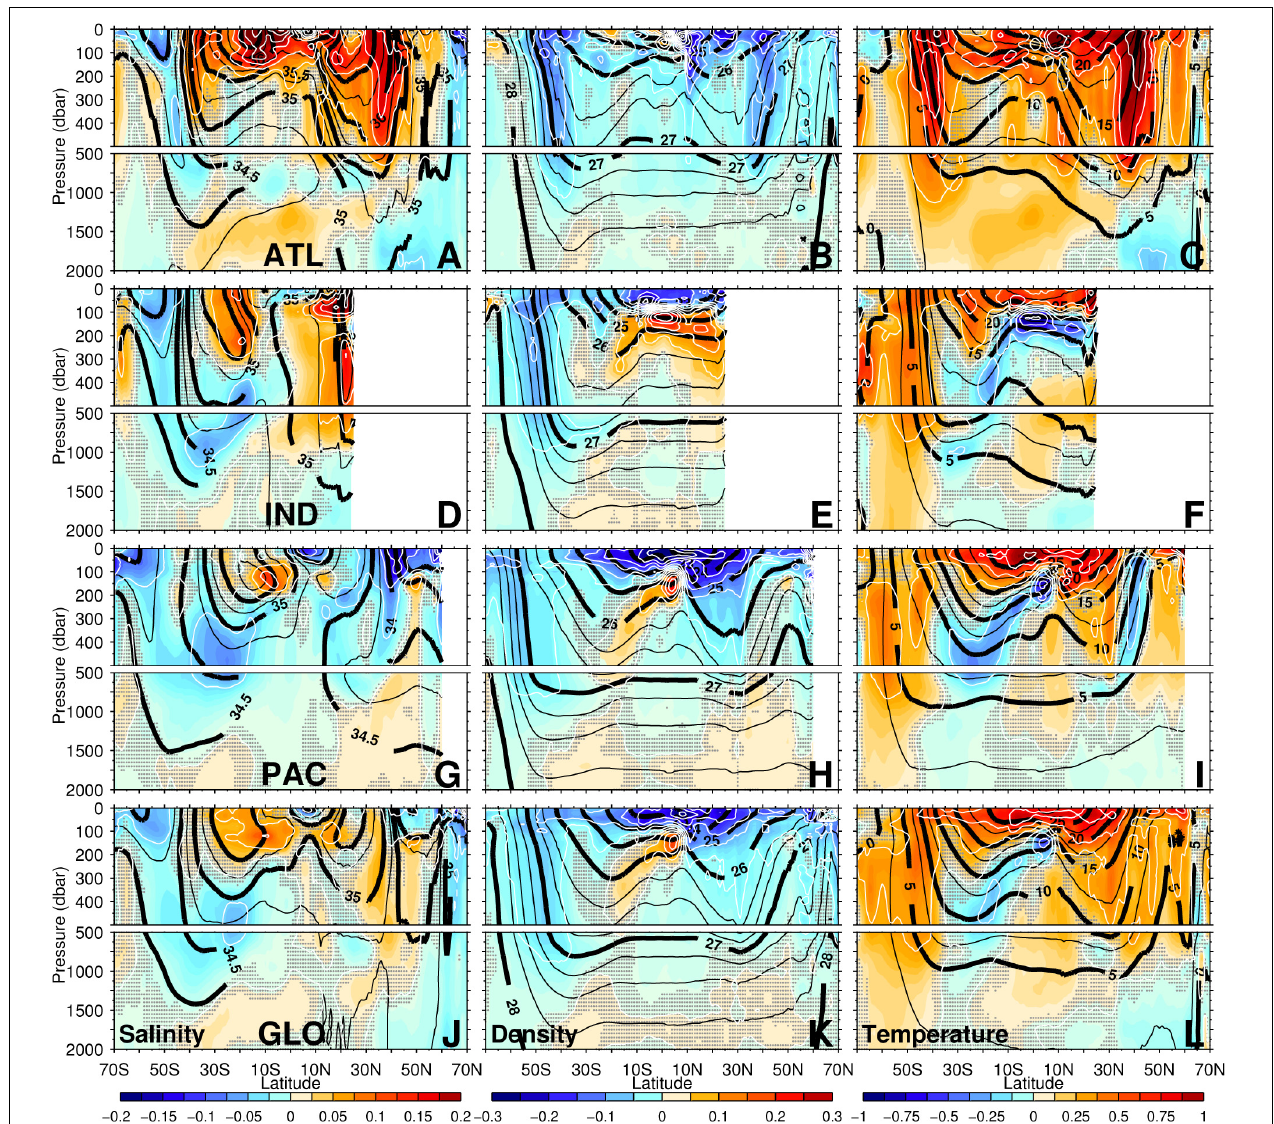
FIGURE 1 | Upper 2000 dbar (pressure) zonally averaged linear trend (1950–2000) (colors with white contours) of salinity changes (column 1, PSS-78 per 50 year; white contours: 0.05 PSS-78, -0.5 to 0.5), neutral density changes (column 2, kg m − 3 per 50 year; white contours: 0.05 kg m − 3 , − 0.3 to 0.3), and potential temperature changes (column 3, ◦ C per 50 year; white contours: 0.25 ◦ C, − 1 to 1), for the Atlantic Ocean (ATL) in row 1 (A–C) , Indian Ocean (IND) in row 2 (D–F) , Pacific Ocean (PAC) in row 3 (G–I) , and global ocean (GLO) in row 4 (J–L) . Mean fields are shown as black lines (Salinity: thick black contours 0.5 PSS-78, thin contours 0.25 PSS-78; Neutral density: thick black contours 1.0 kg m − 3 , thin contours 0.25 kg m − 3 ; Potential temperature: thick black contours 5.0 ◦ C, thin contours 2.5 ◦ C). Trends are calculated on pressure surfaces. Regions where the resolved linear trend is not significant at the 90% confidence level are stippled in gray. Reproduced from IPCC AR5 (Rhein et al., 2013, Figure